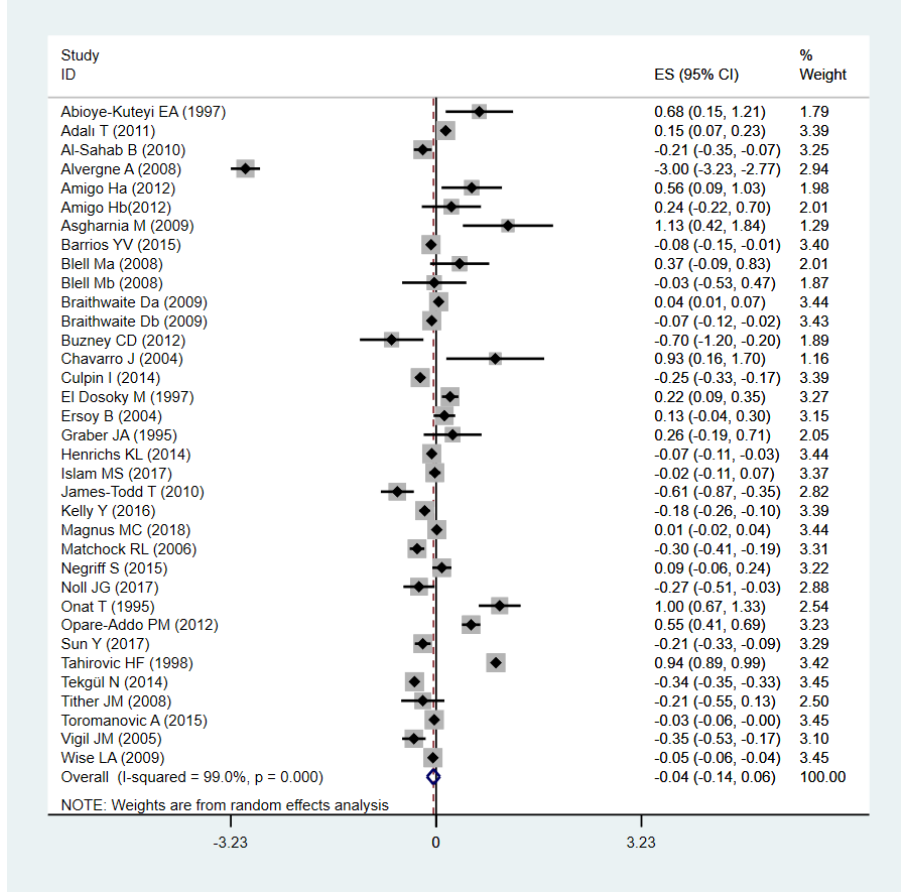
Figure 2. Forest plot of effect sizes reported as Cohen’s d (x-axis) evaluating adverse childhood experiences (ACEs) and early pubertal timing using the random effects model.